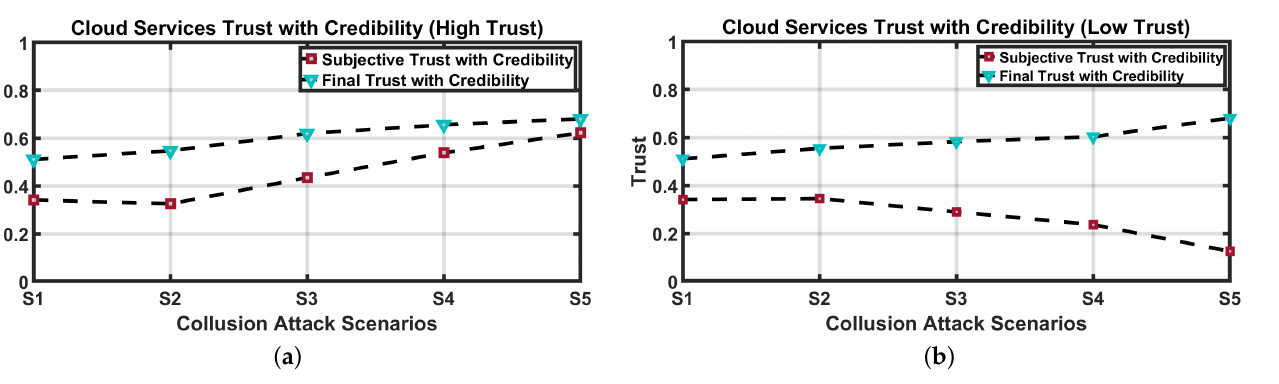
Figure 4. Cloud Services Trust with Credibility: ( a ) High Trust and ( b ) Low